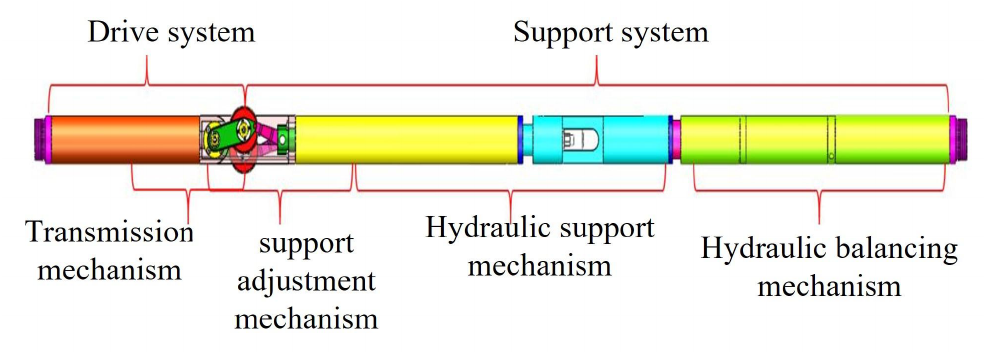
Figure 1. The overall structure model of the WDR with the push rod − spring support adjustment mechanism.